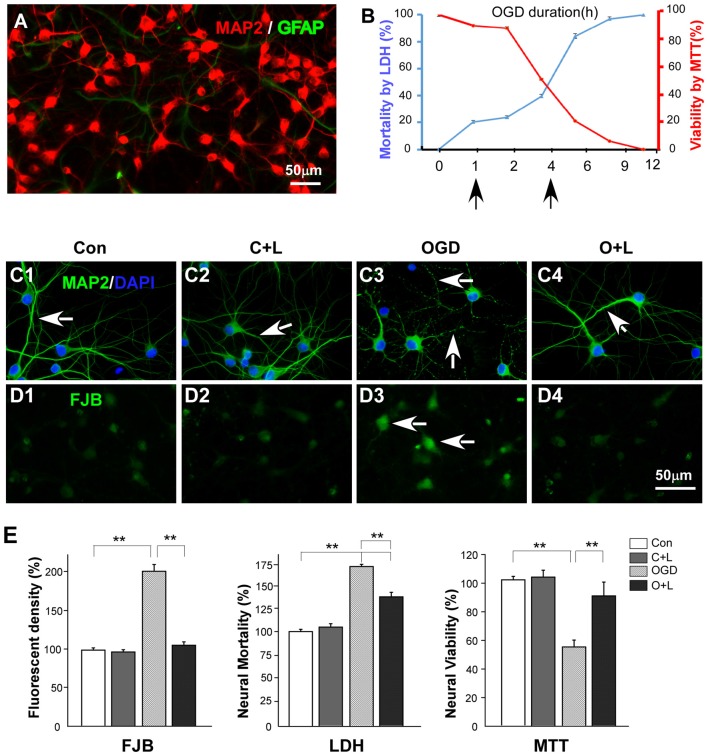
Effects of LBP on neuronal viability and mortality. (A) Immunochemistry staining showing that the majority of the cultured cells are neurons (MAP2 positive cells, red) with few astrocytes (GFAP positive cells, green). (B) Two slopes showing the relationship between neuronal viability (red slope), death (blue slope) and oxygen-glucose deprivation (OGD) duration. (C) Immunochemistry staining showing effects of LBP treatment on morphological changes of neurons exposed to 4 h OGD. Neurons exhibited features of beaded dendrites in the OGD group (C3, arrows). However, LBP recovered normal dendritic morphology (C4, arrow). (D) Fluoro JADE B (FJB) staining (injury marker) showing strong fluorescent labeling in most neurons when exposed to OGD for 4 h (D3, arrows). However, LBP treatment reduced the staining intensity (D4, arrow). (E) Quantitative results showing effects of LBP treatment on neuronal injury (FJB staining), mortality and viability when exposed to 4 h OGD (**P < 0.01). The scale bar in (D4) is equal to (C1–C4) and (D1–D3).